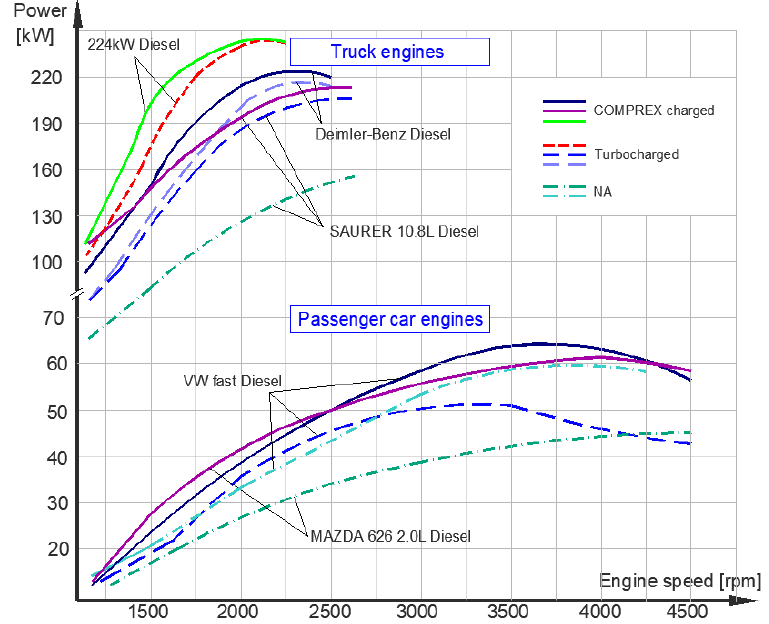
Figure 6. Comparative power output for passenger car engines and truck engines (upper dia- grams)—(1984–1990). Made based on